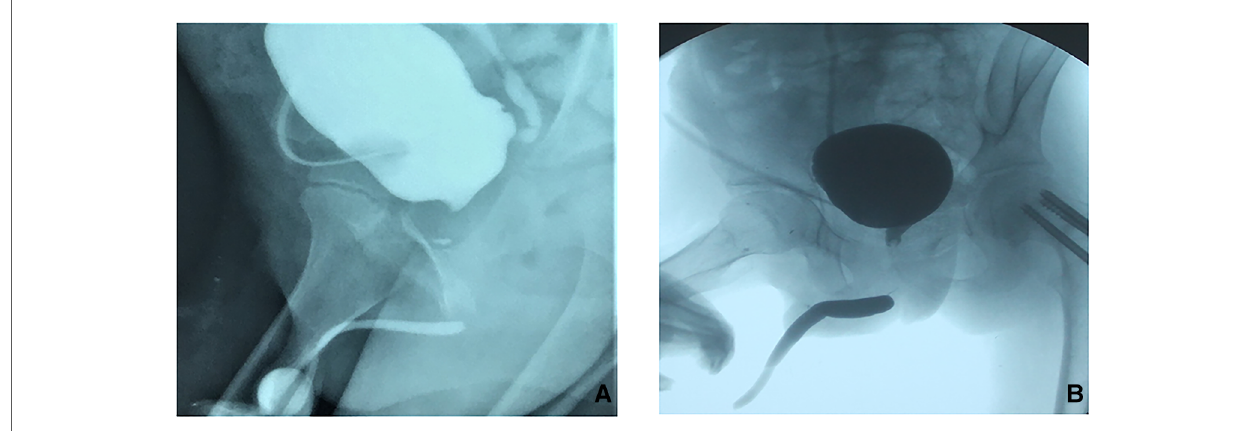
FIGURE 1 Preoperative cystourethrography of boy with complicated long posterior urethral stricture ( A ): Urethral angiography indicates long posterior urethral stenosis; ( B ): Urethral angiography indicates that the bladder fl oats up and the proximal opening of the posterior urethra is